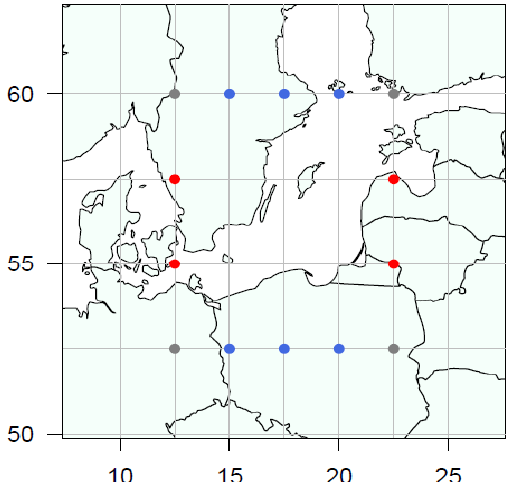
Figure 4. Grid-points used to calculate zonal (blue and grey dots) and meridional (red and grey dots) circulation indices.